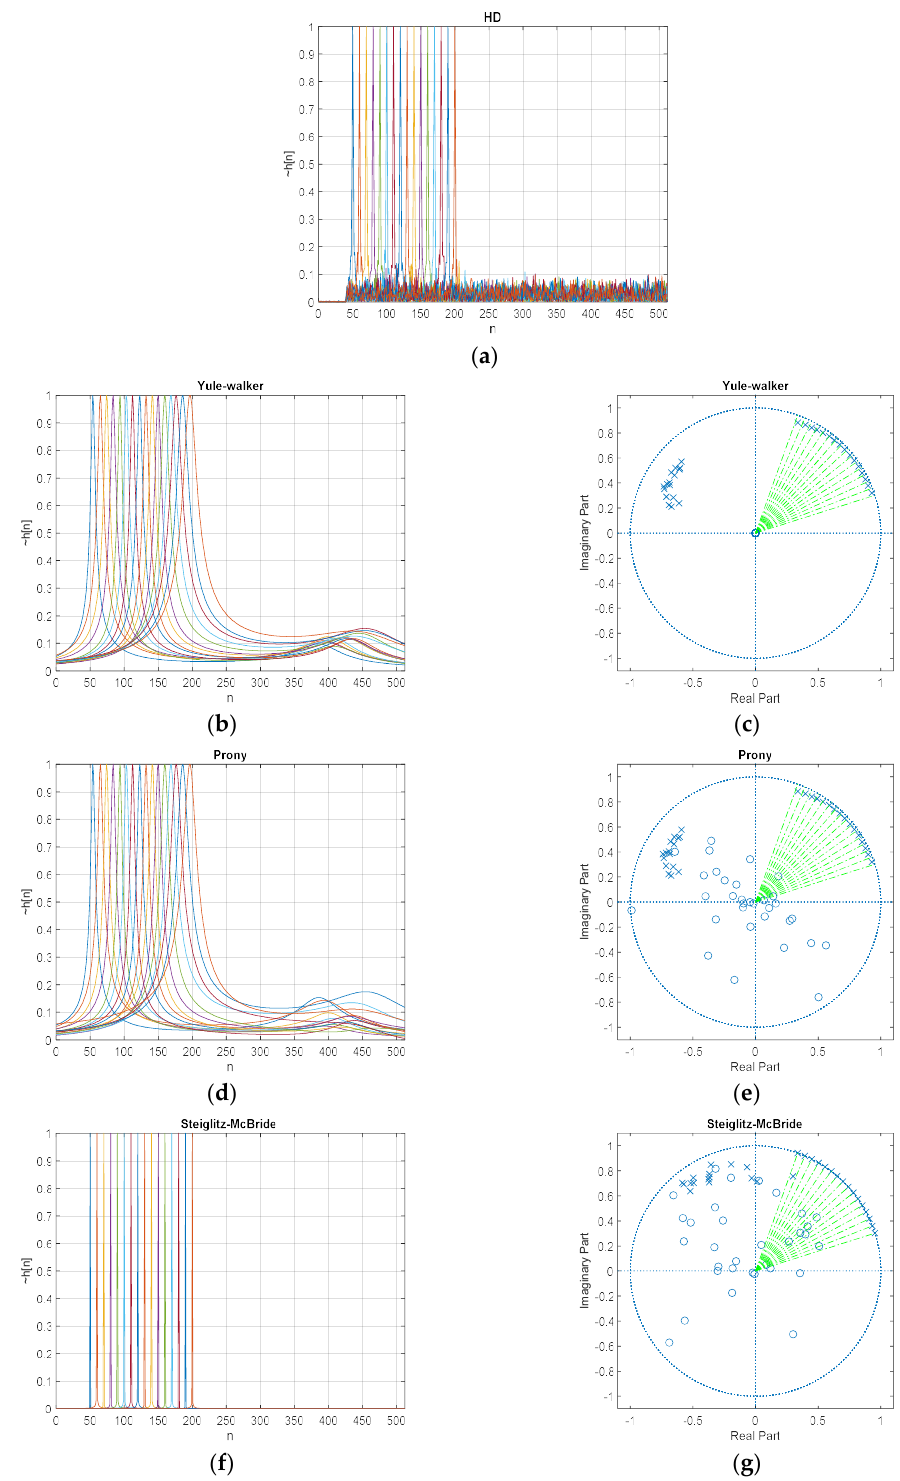
Figure 7. Estimated (cid:101) h [ n ] distribution (normalized) and pole-zero plot with 20 dB SNR & 20 ensemble average for ToF (50~200 in 10 sample interval) from: ( a ) non-parametric HD; ( b ) Yule-walker HD; ( c ) corresponding pole-zero plot; ( d ) Prony HD; ( e ) corresponding pole-zero plot; ( f ) Steiglitz-McBride HD; ( g ) corresponding pole-zero plot. The pole/zero locations are indicated by x/o mark, respectively. The green dotted vector specifies the desired pole location e 2 π d / L (FFT length L ) from the given delay d